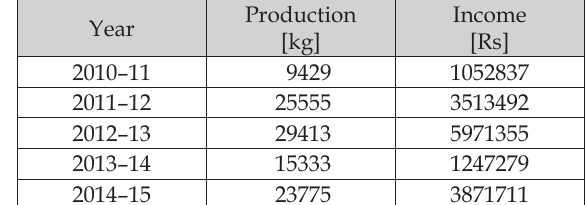
Table 5. The year range wise income and production.